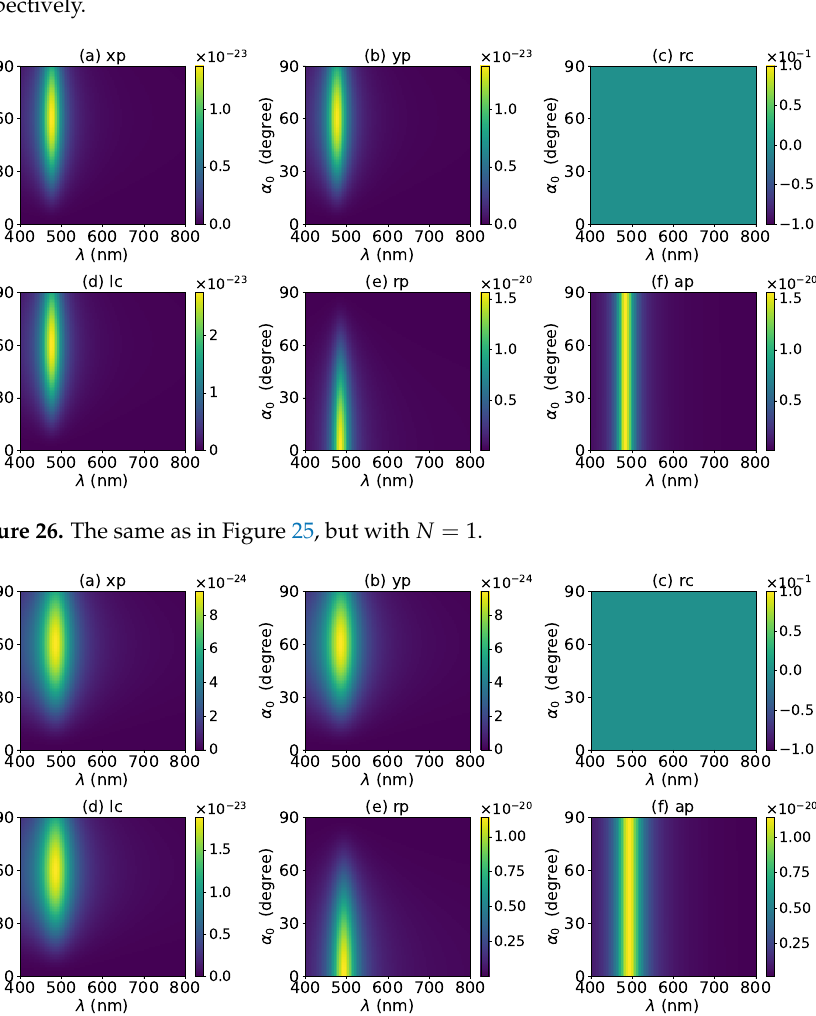
Figure 27. The same as in Figure 25, but with N =